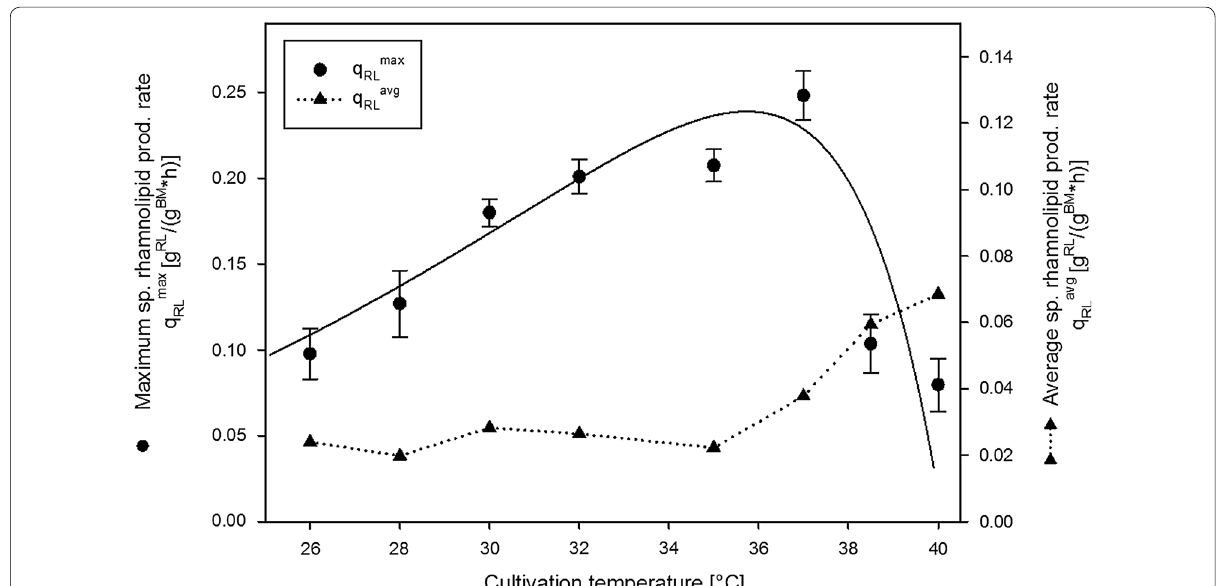
Fig. 3 Maximum (circles) and average (triangles) specific rhamnolipid production rates at different cultivation temperatures. Maximum specific rhamnolipid production rates as a function of temperature was described using the empirical modified Ratkowsky equation (Eq. 1) (Ratkowsky et al. 1983; Zwietering et al. 1991), with parameter fitting performed for the obtained data (black line)